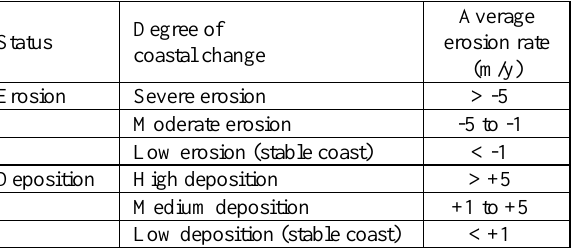
Table 2. The rate of coastal change